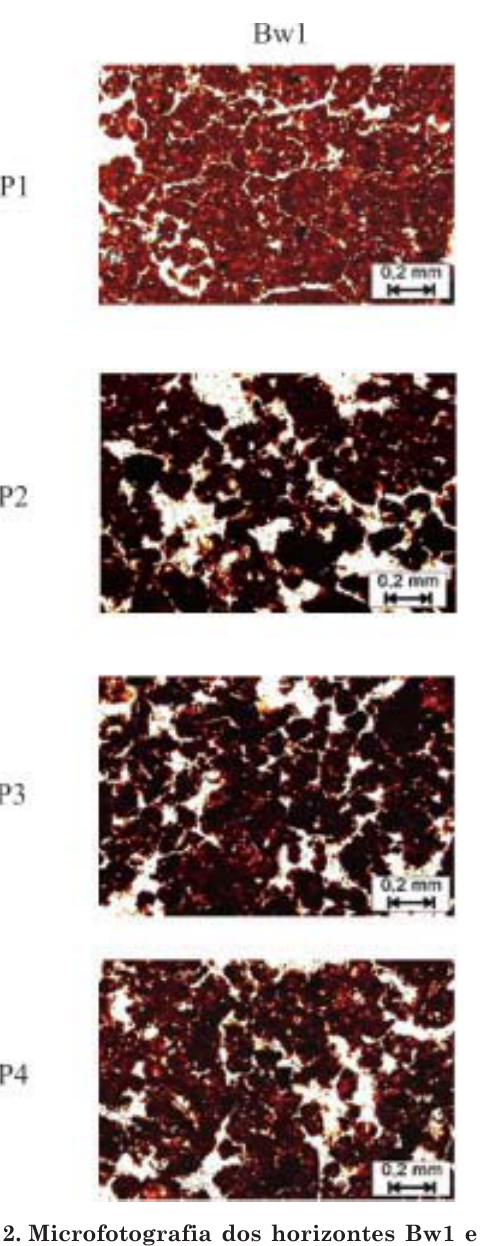
Figura 2. Microfotografia dos horizontes Bw1 e Bw2 do Latossolo Vertmelho distroférrico húmico de diferentes perfis na toposseqüência (detalhes da posição dos perfis na paisagem - Quadro